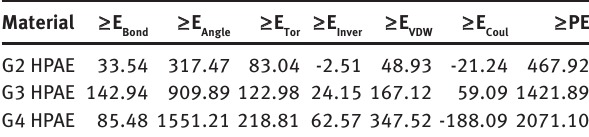
Table 5 Energy change in G2–G4 HPAE systems (KJ/mol).